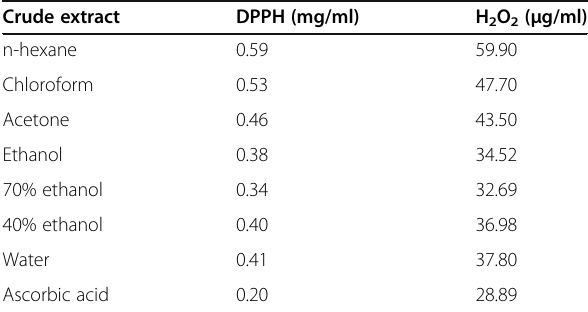
Table 2 IC 50 values of various MZFP extracts by in vitro radical scavenging